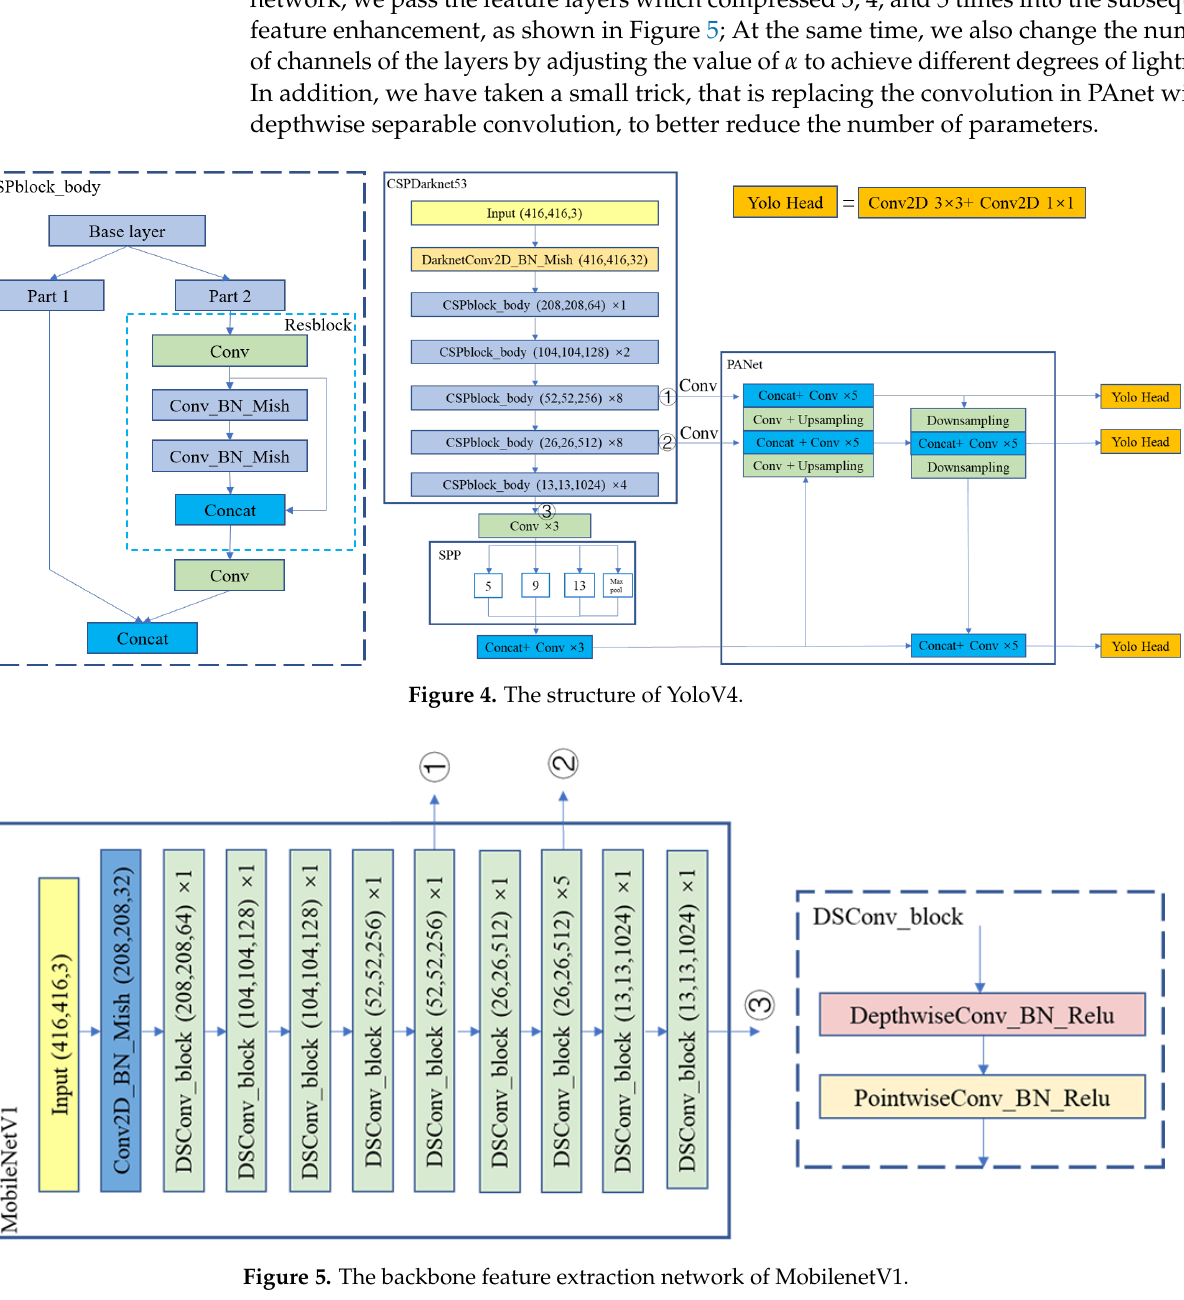
Figure 5. The backbone feature extraction network of